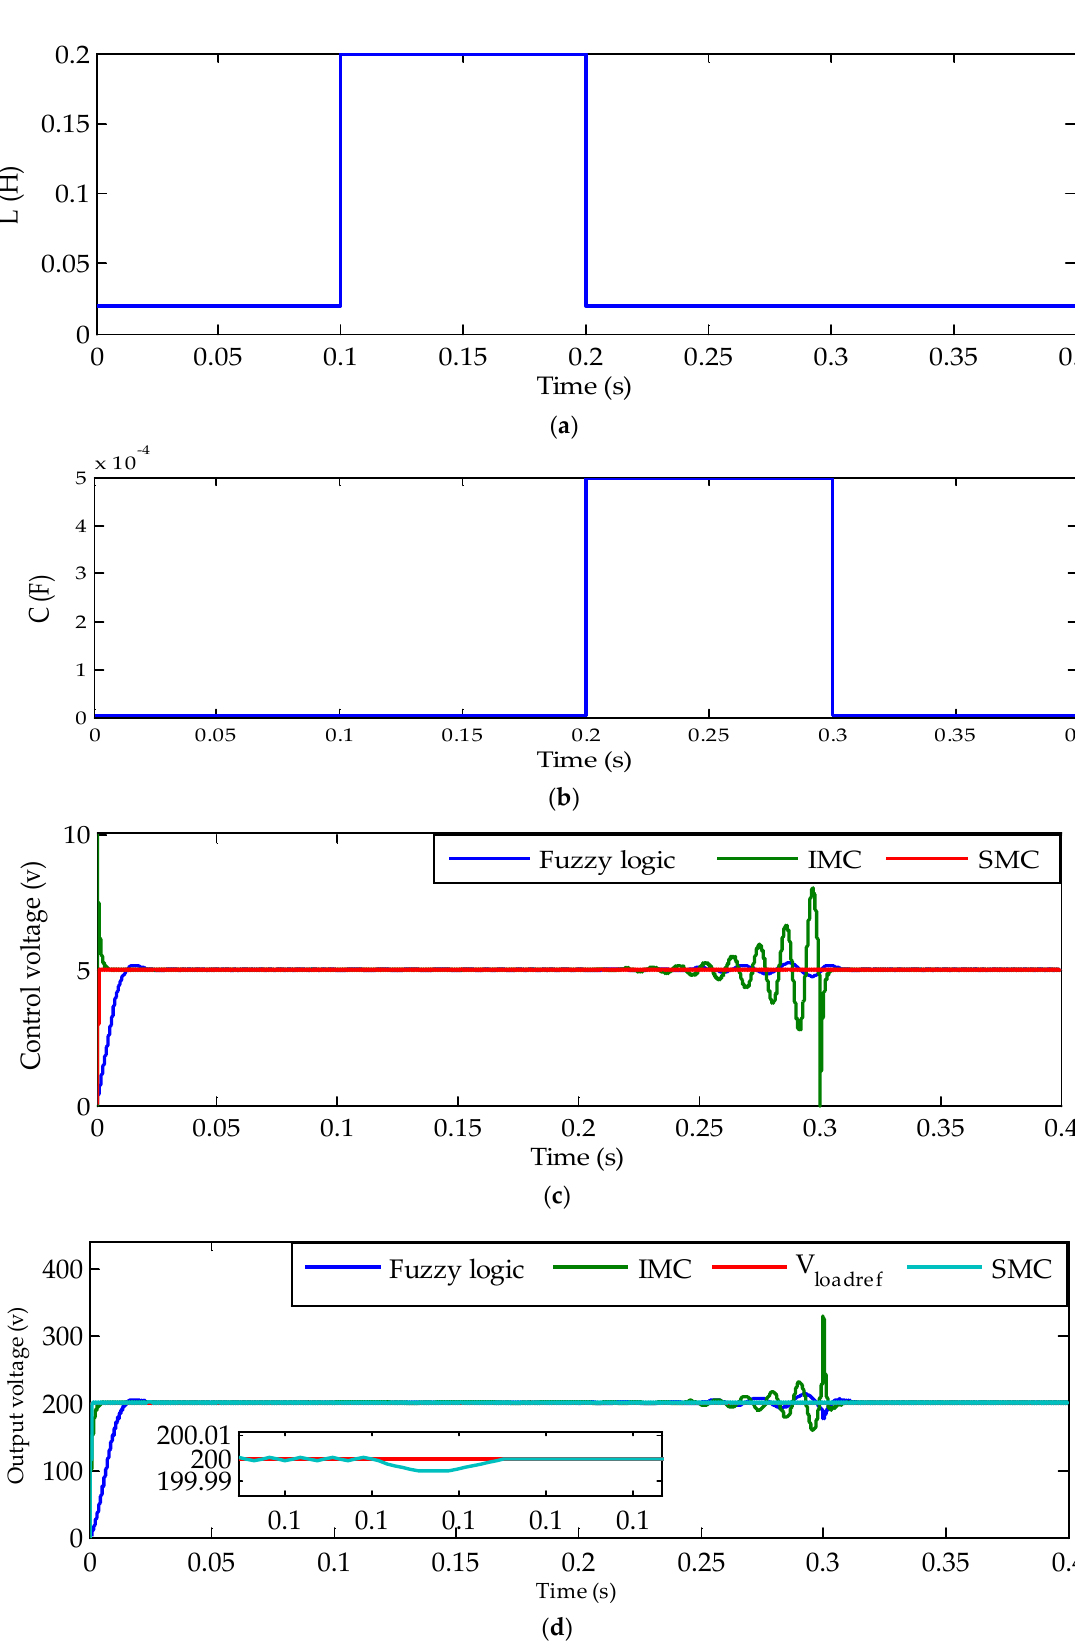
19 of 22 ( c ) Figure 11. Resistor load variation: ( a ) evolution of the control voltage and ( b ) evolution of target and ( c ) actual output voltages. 6.6. Controller’s Behavior under DC-DC Buck Converter Parameter Variations As is well known, the PI and IP controllers are sensitive to system parameter varia- tions. Thus, in this case, only the behavior of FLC, IMC, and the proposed SMC algorithms are tested. The DC input voltage, the load resistor, and the target output voltage are all